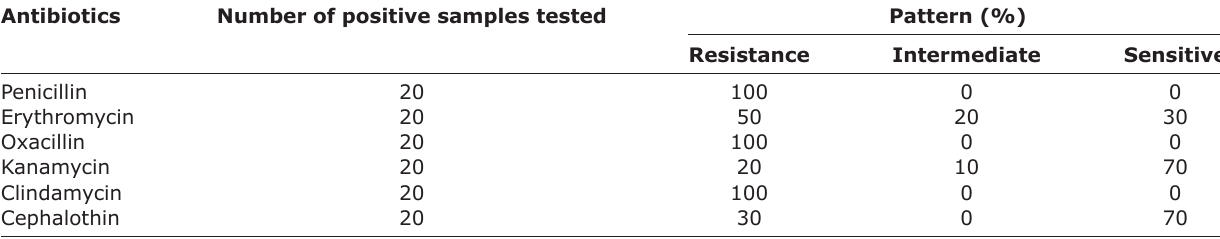
Table-2: Antimicrobial resistance pattern of Salmonella isolates from house crows. Antibiotics